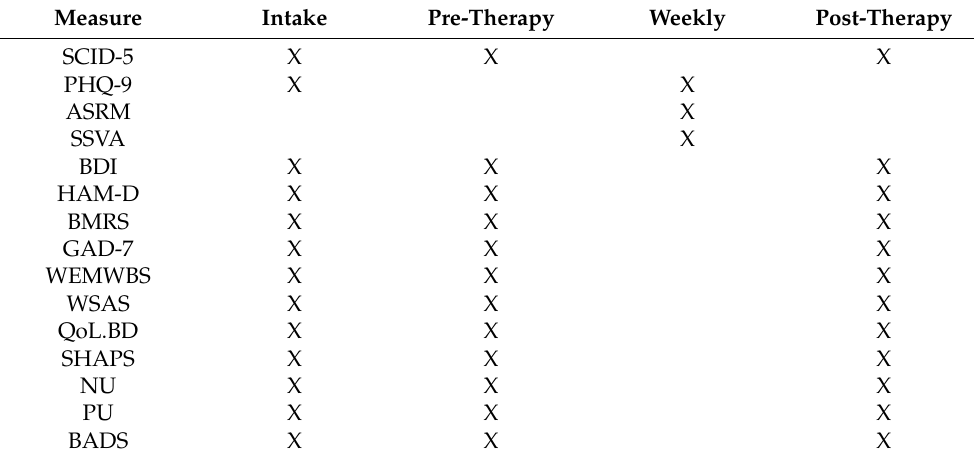
Table 1. Measures completed at each stage of the